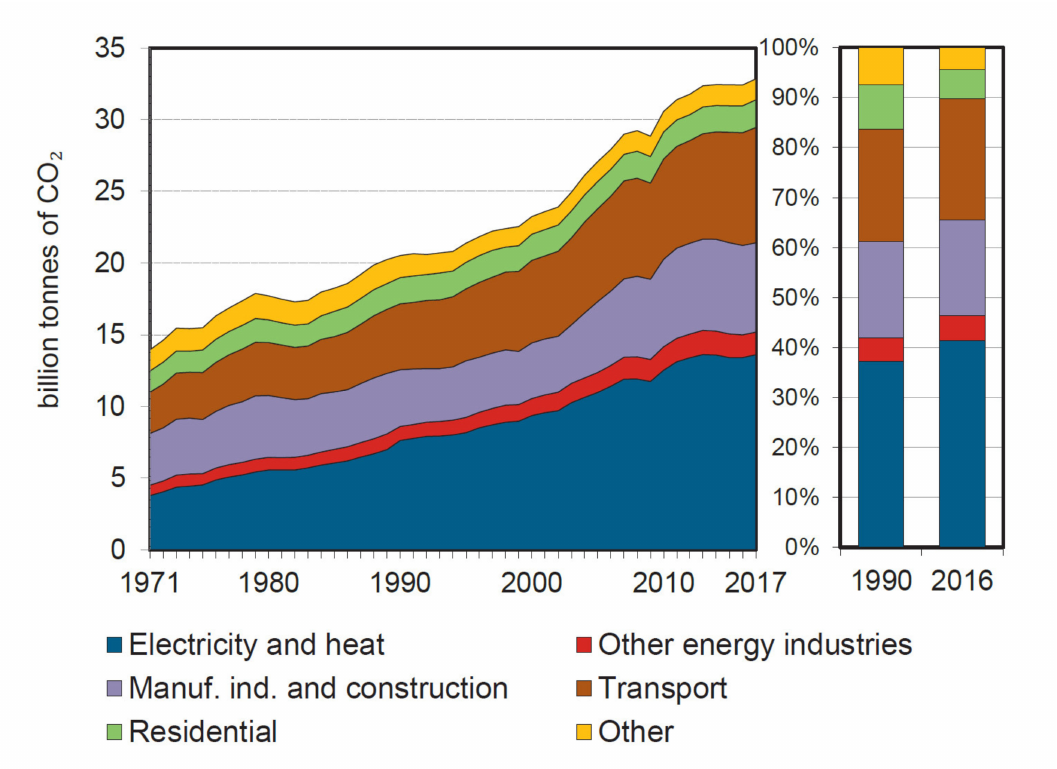
Figure1. GlobalCO 2 emissionsbysector from 1971to2017accordingto theInternationalEnergyAgency (IEA) [2]. Source: IEA (2019) CO 2 Emissions from Fuel Combustion—Highlights. All rights